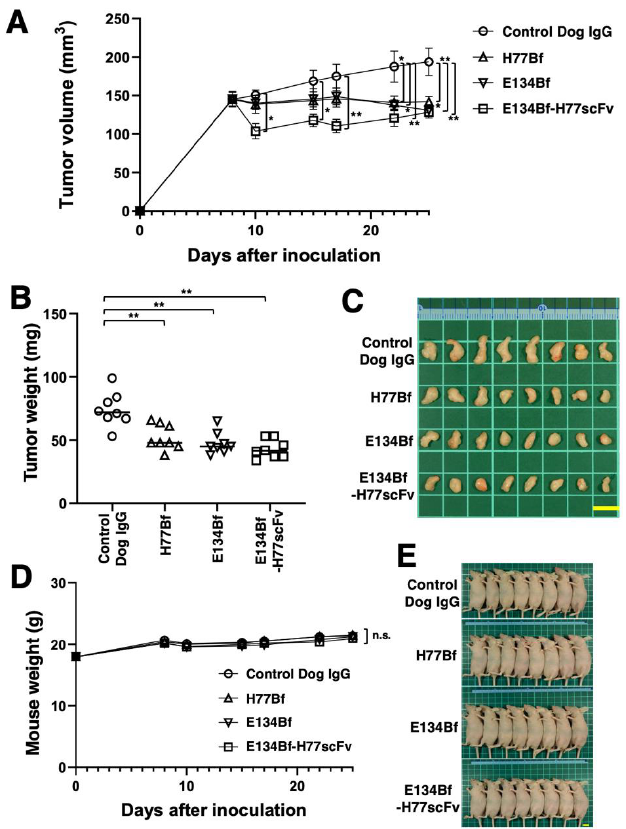
Figure 5. Antitumor activity of E134Bf, H77Bf, and E134Bf-H77scFv. ( A ) Evaluation of tumor volumes in D-17 xenograft. D-17 cells (5 × 10 6 cells) were subcutaneously inoculated into mice. On day 8 after the inoculation of D-17 cells, 100 µ g of E134Bf, H77Bf, E134Bf-H77scFv or control dog IgG were injected intraperitoneally. Additional antibodies were injected on days 15 and 22. Canine MNCs were also injected surrounding tumors on days 8, 15, and 22. The tumor volume was determined on days 8, 10, 15, 17, 22, and 25. Values are presented as the mean ± SEM. ** p < 0.01 and * p < 0.05 (ANOVA and Sidak’s multiple comparisons test). ( B ) Xenograft weight (day 25) was measured. Values are presented as the mean ± SEM. ** p < 0.01 (Welch’s t test). ( C ) Resected xenografts appearance of from the indicated groups on day 25 (scale bar, 1 cm). ( D ) Mice body weights inoculated with D-17 xenografts on days 8, 10, 15, 17, 22, and 25 (ANOVA and Sidak’s multiple comparisons test). n.s., not significant. ( E ) Body appearance of D-17- inoculated mice on day 25 (scale bar, 1